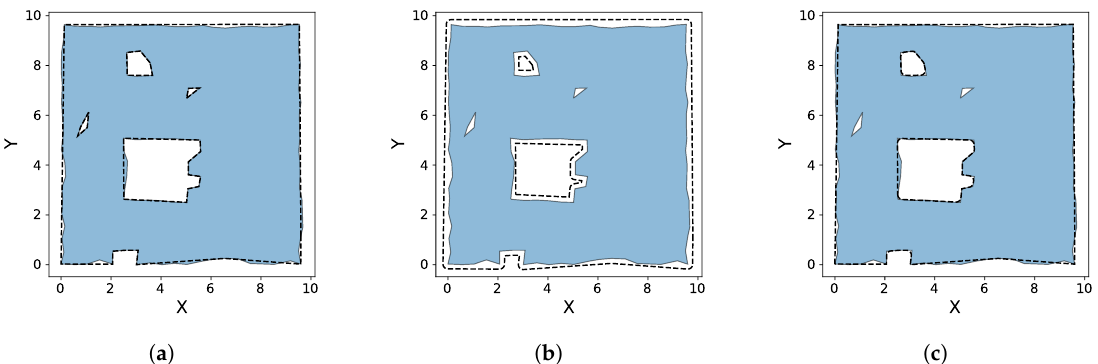
Figure 15. An example of polygon post processing. The shaded blue polygon is the original polygon extracted (see Figure 14c). All dashed lines indicate a new polygon generated from a step of post processing. ( a ) The polygon is simplified; ( b ) The polygon is applied a positive buffer. Two small holes have been “filled” in; ( c ) The polygon is applied a negative buffer; only two holes